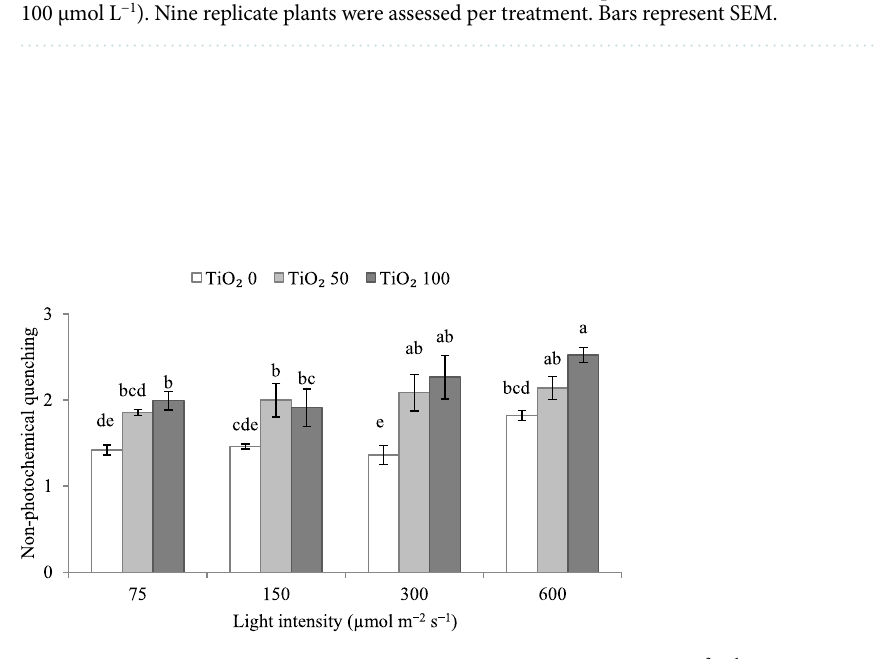
Figure 11. Effect of cultivation light intensity (75, 150, 300 and 600 µmol m −2 s −1 ) and spray treatment (once a week, and three times in total) with titanium dioxide (TiO 2 ) nanoparticles (open, grey, and dark grey for 0, 50 and 100 µmol L −1 , respectively) on non-photochemical quenching (equation and explanation in Table 3) of radish cv. Cherry belle plants. Nine replicate plants were assessed per treatment. Bars represent SEM. The interaction of the two factors (light intensity, TiO 2 nanoparticle level) was significant, and different letters indicate significant